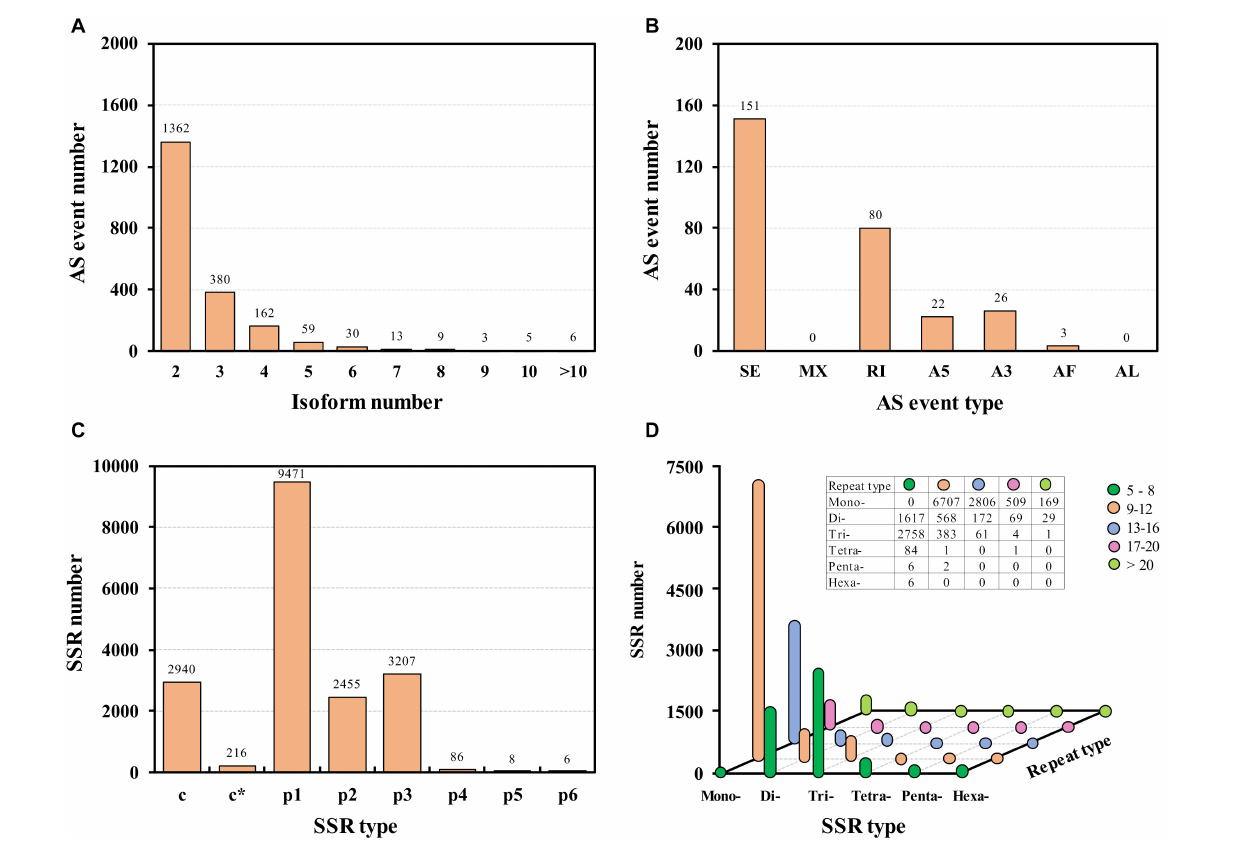
FIGURE 3 | Alternative splicing (AS) events (A,B) and single sequence repeat (SSR) identification (C,D) . SE, skipping exon; MX, mutually exclusive exons; RI, retained intron; A5, alternative 5 (cid:48) splice sites; A3, alternative 3 (cid:48) splice sites; AF, alternative first exons; AL, alternative last exons; c, combined SSR; c*, combined and overlapping SSR; p1, mono-represent mononucleotide repeats; p2, di-represent dinucleotides repeats; p3, tri-represent trinucleotides repeats; p4, tetra-represent tetranucleotides repeats; p5, penta- represent pentanucleotides repeats; p6, hexa- represent hexanucleotides